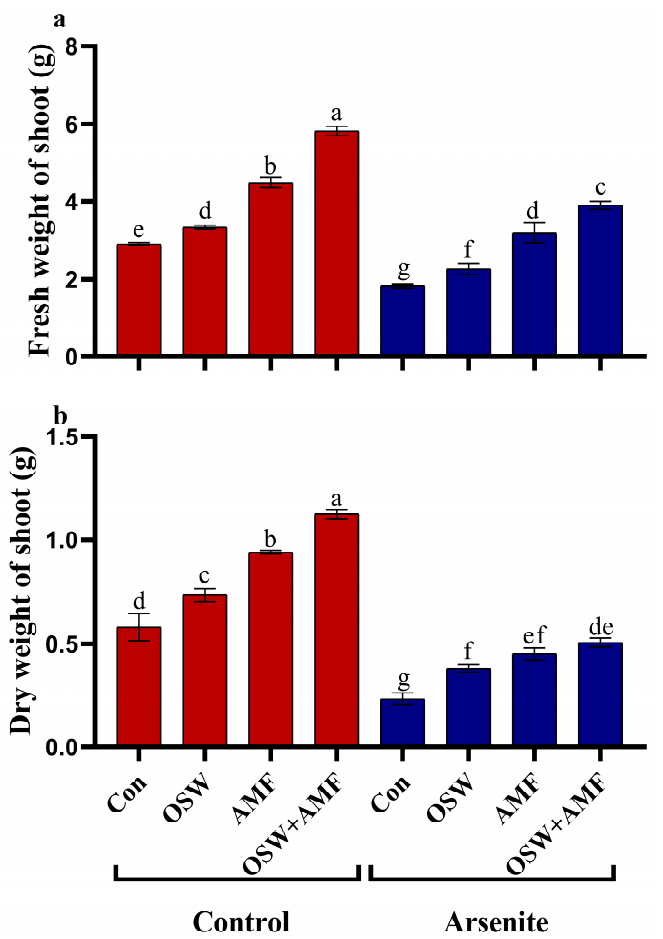
Figure 1. The influence of olive solid waste (OSW) and arbuscular mycorrhizal fungi (AMF), com- bination (OSW + AMF) on ( a ) fresh weight of shoot and ( b ) dry weight of shoots in wheat plants growing under As III stress. Fishers test at p < 0.05 reveals significant variations in means ( ± standard deviation), which are different letters on the same bars.